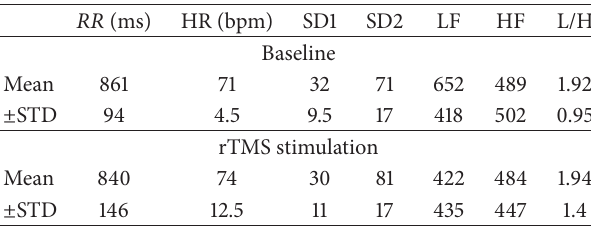
Table 4: General